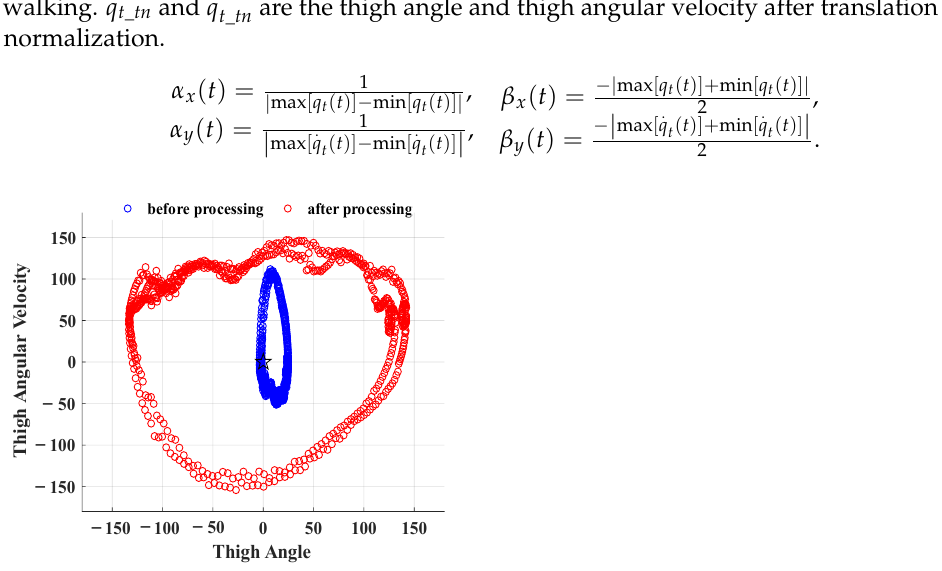
Figure 1. Phase scatter diagrams of thigh motion and the pentagram represents the origin. The maximum and minimum values in Equation (4) are calculated in real-time from the data of the previous gait cycle. The phase scatter diagrams before and after processing are shown in Figure 1. After processing, the phase diagram is close to a circle centered on the